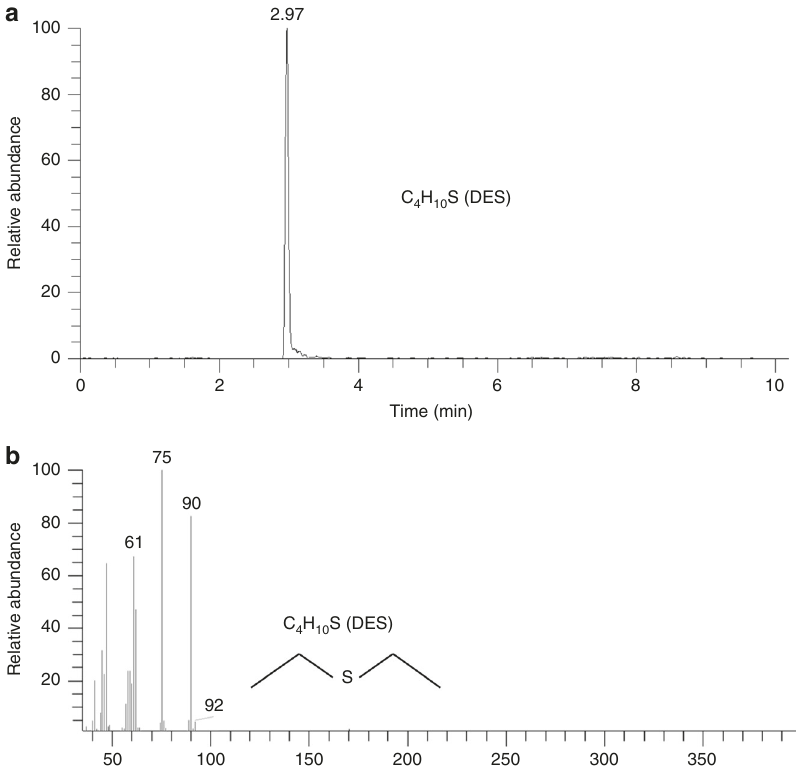
Fig. 6 GC-MS measurement. The extracted chromatogram ( m / z 90) and DES mass spectra (DES = m / z 90) were taken from the Li anode of the Li – O 2 cell with 50 mM TESI after 60 cycles. a Extracted chromatogram. b DES mass spectra (DES = m / z